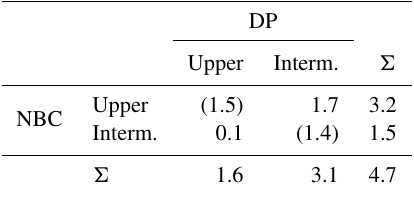
Table 2. Same as Table 1 but for waters with DP